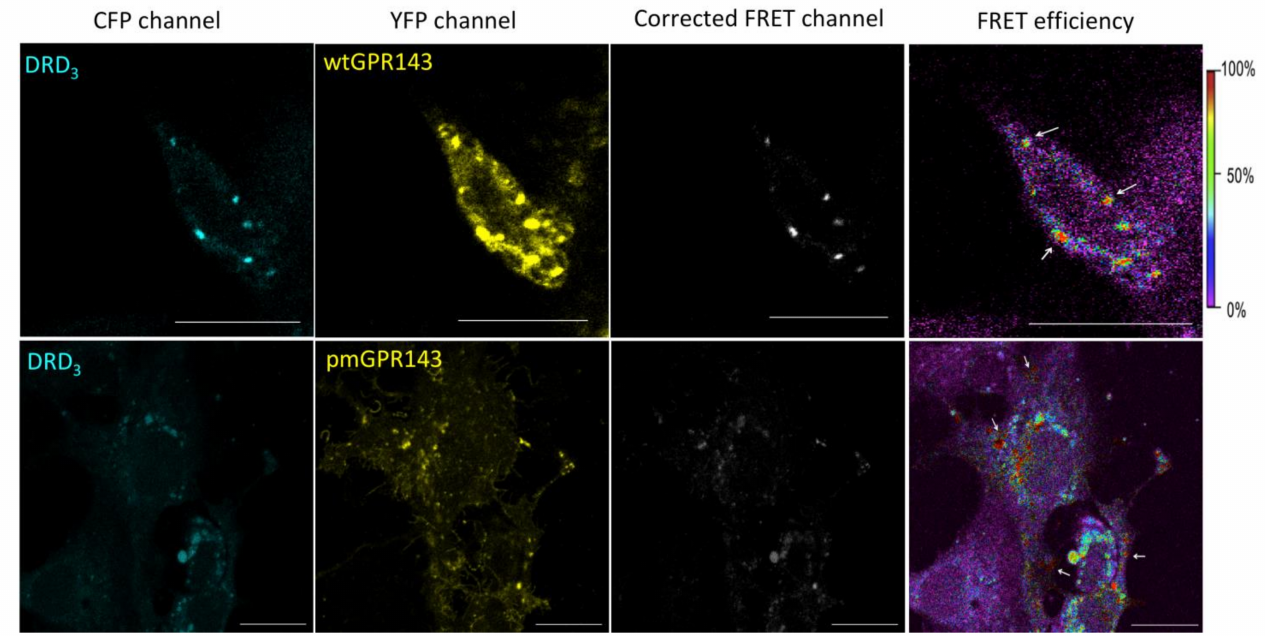
Figure 1. FRET of GPR143-YFP and DRD 2 -CFP in COS7 cells. The sensitized emission method was used to detect interaction between GPR143 (YFP channel) and DRD 2 (CFP channel). FRET signal, corrected by CoA and CoB parameters, and FRET efficiency (color scale on the far right) are shown. White arrows indicate regions where FRET signal is localized. Controls are shown in Figure S2. Scale bar = 20 µ m.